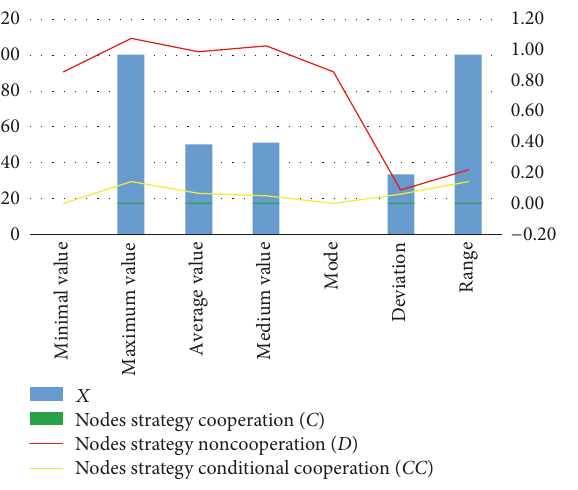
Figure 20: The state of population when 𝑋 = (0, 100, 53.64, 55, 0, 30.97, 100). Table 14: The statistical analyses of strategies 𝐶 , 𝐷 , and 𝐶𝐶 .